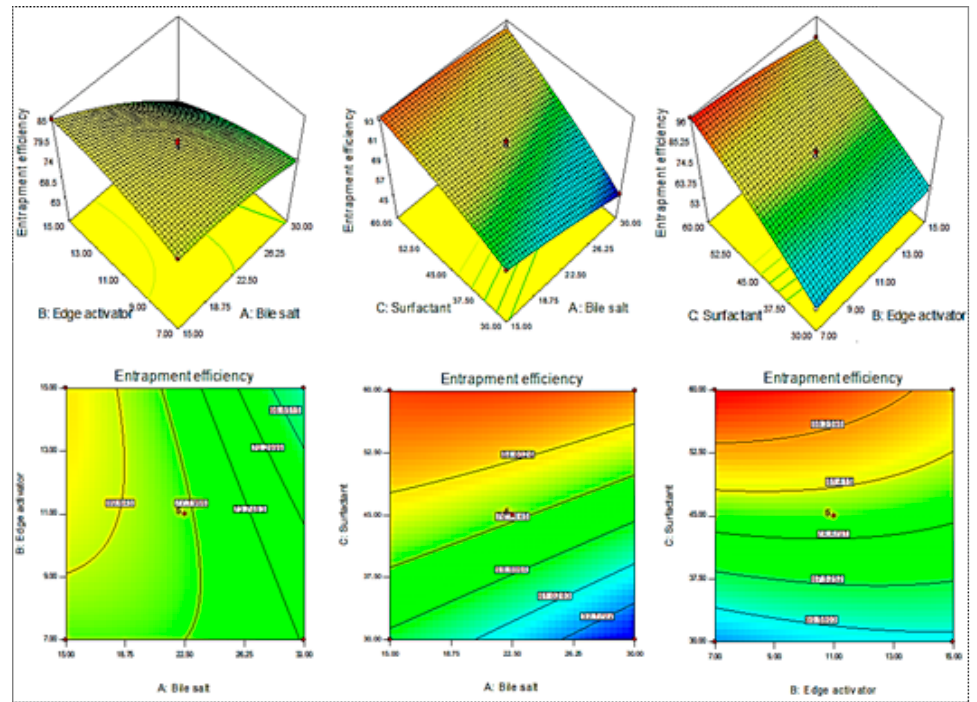
Figure 3. Effect of independent variables (A) sodium deoxycholate, (B) Cremophor EL, and (C) Span 60 on entrapment efficiency (Y 2 ).